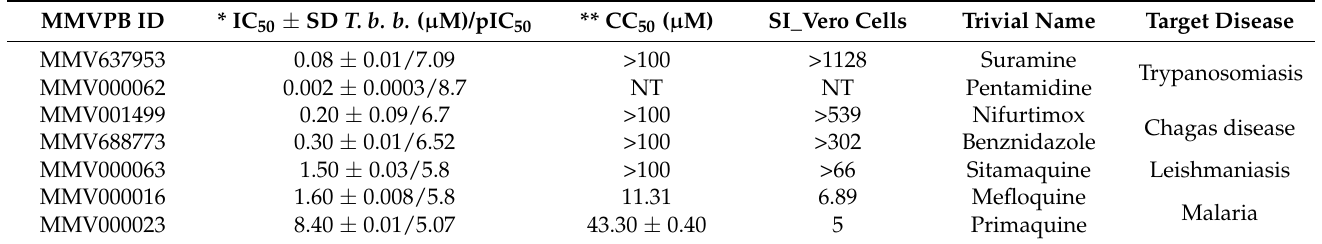
Table 1. Antitrypanosomal activity of reference drugs included in the MMV Pathogen